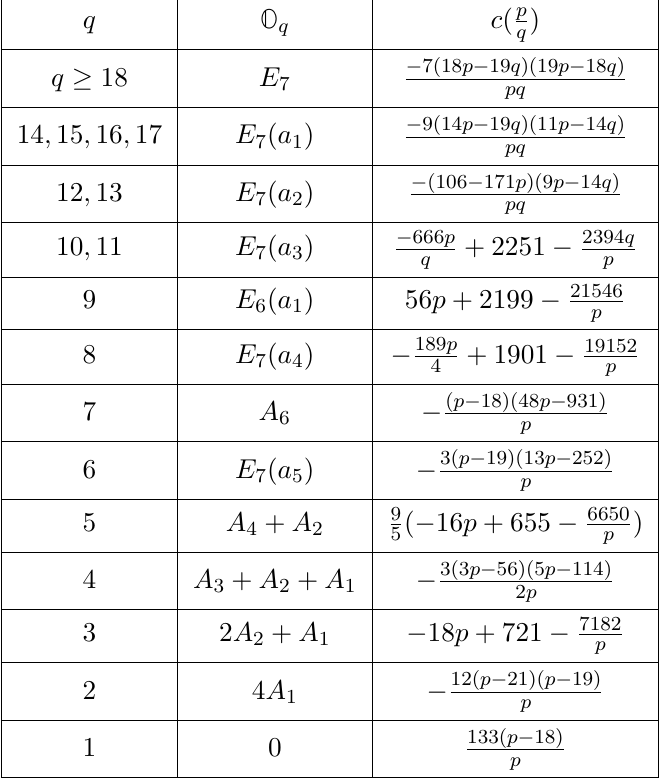
Table 9 . Orbits in E 7 Lie